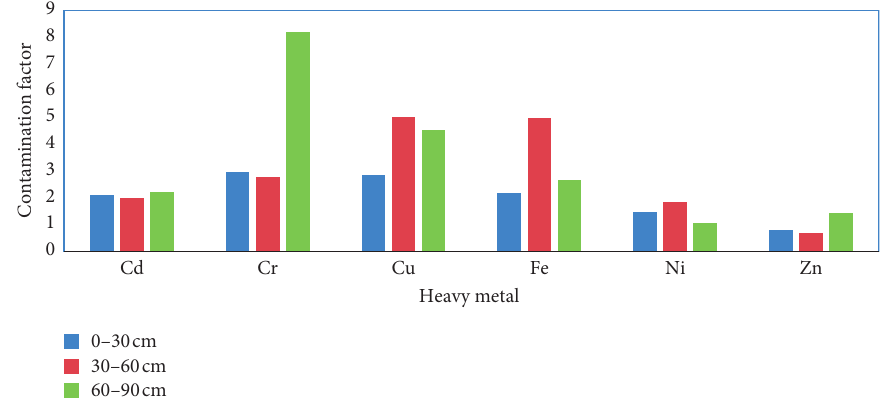
Figure 5: Heavy metal contamination in soils at different depths at the closed landfill.